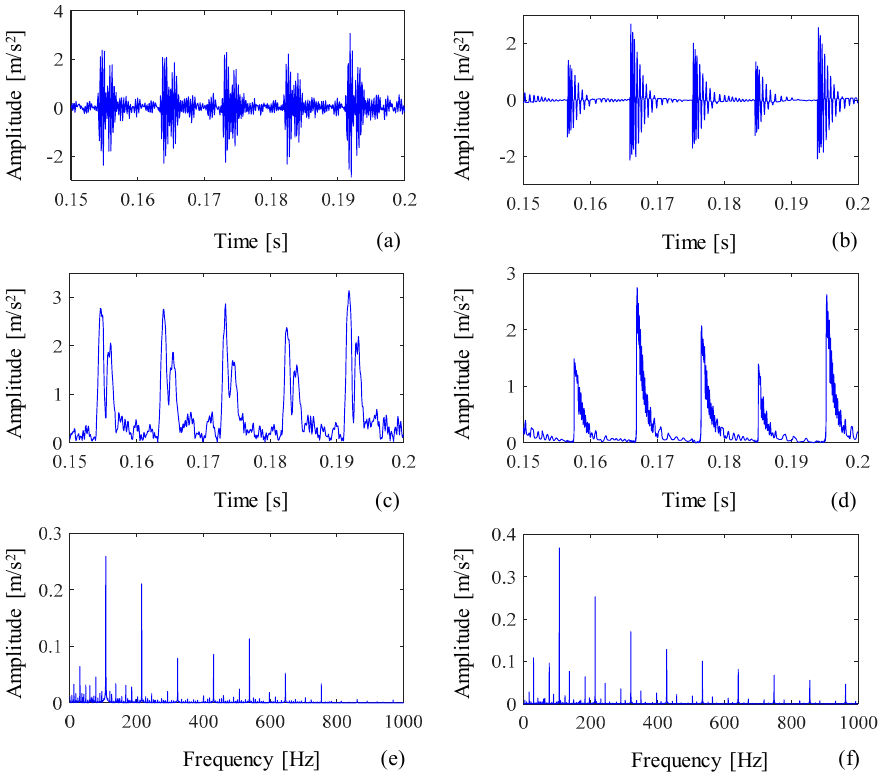
Figure 6. Real and simulation data with outer race fault: ( a , c , e ) are the original data, the envelop data, and the frequency spectrum of the real envelop data; ( b , d , f ) are the original data, the envelop data, and the frequency spectrum of the simulation envelop